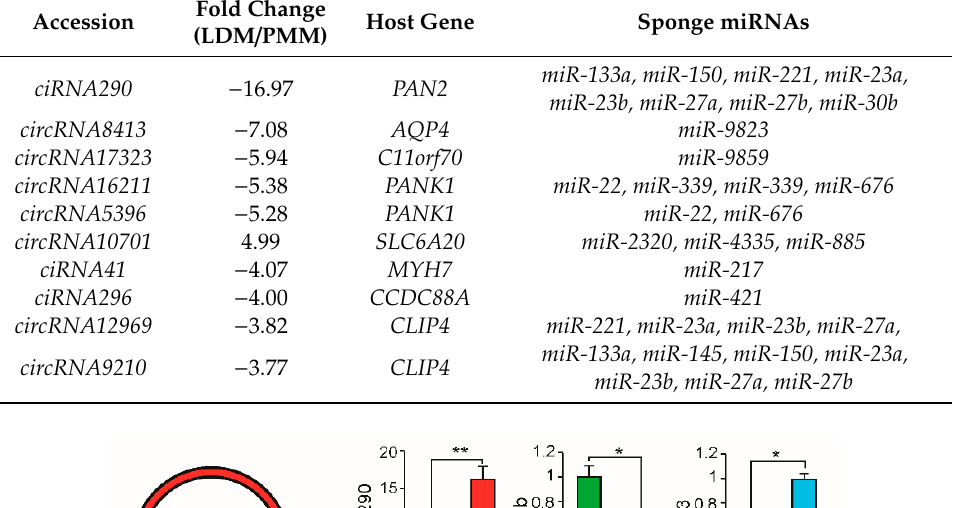
Table 2. The top ten differentially expressed circRNAs between LDM and PMM.